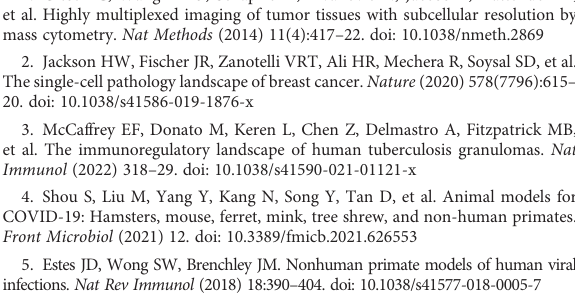
SUPPLEMENTARY TABLE 1 Antibodies not included in the imaging mass cytometry panel and reason for